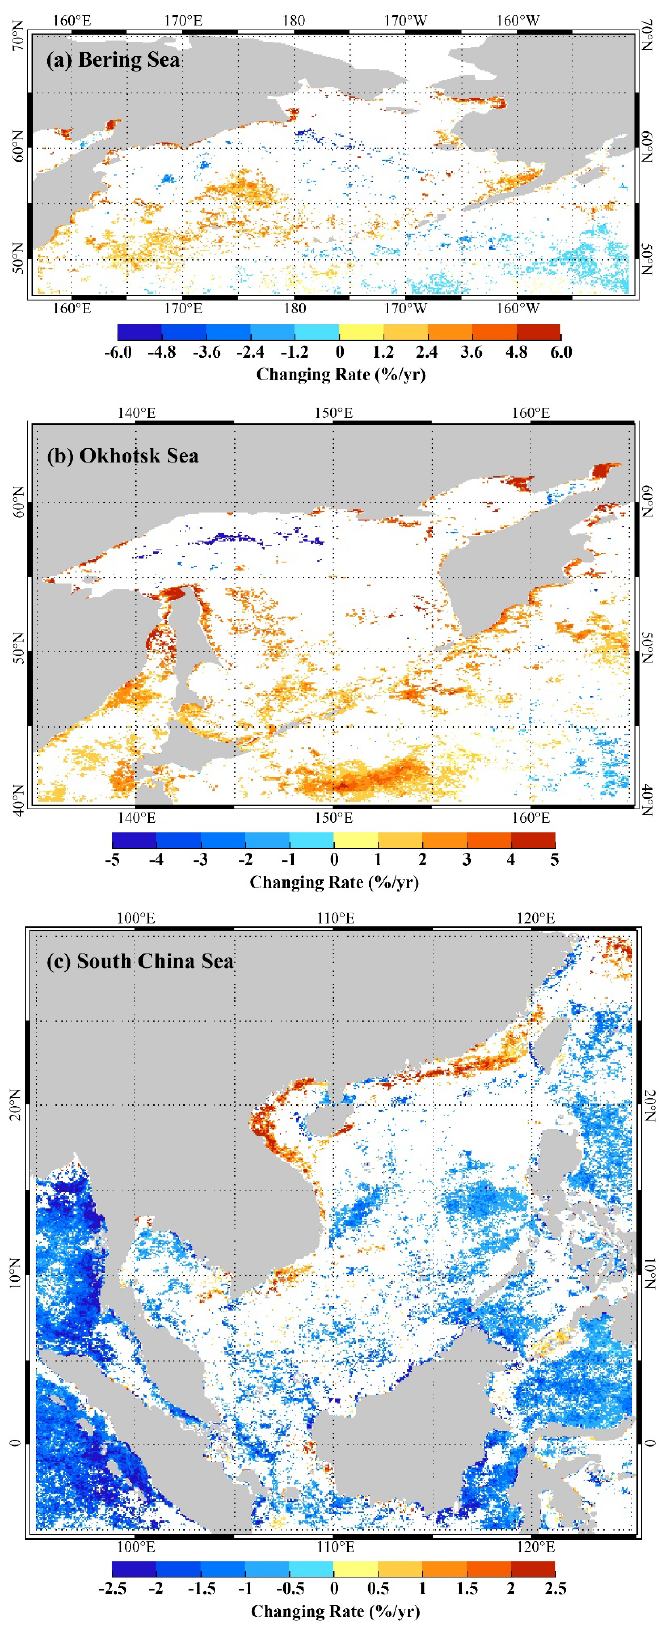
Figure 4. Chlorophyll trends in the ( a ) Bering, ( b ) Okhotsk, and ( c ) South China Seas during 1998–2018 (bright colors show pixels with p < 0.1).